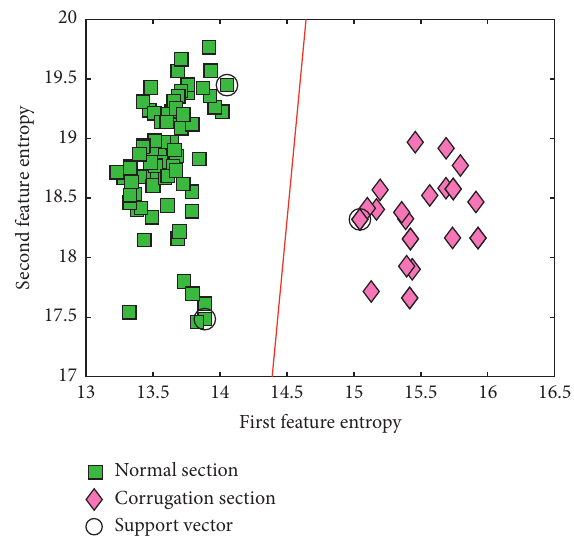
Figure 10: The training results for the Support Vector Machine